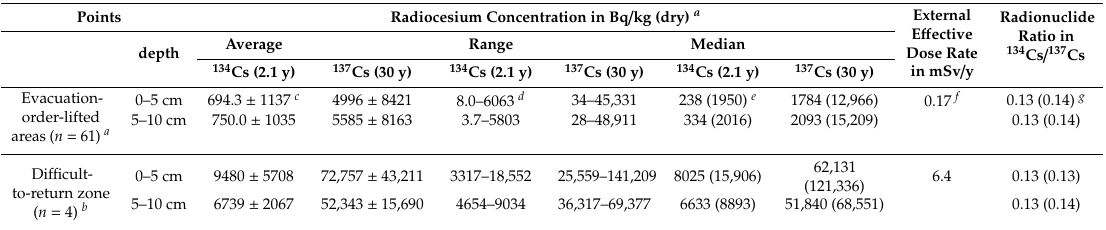
Table 2. Distribution of radiocesium in soil samples in Tomioka town, Fukushima